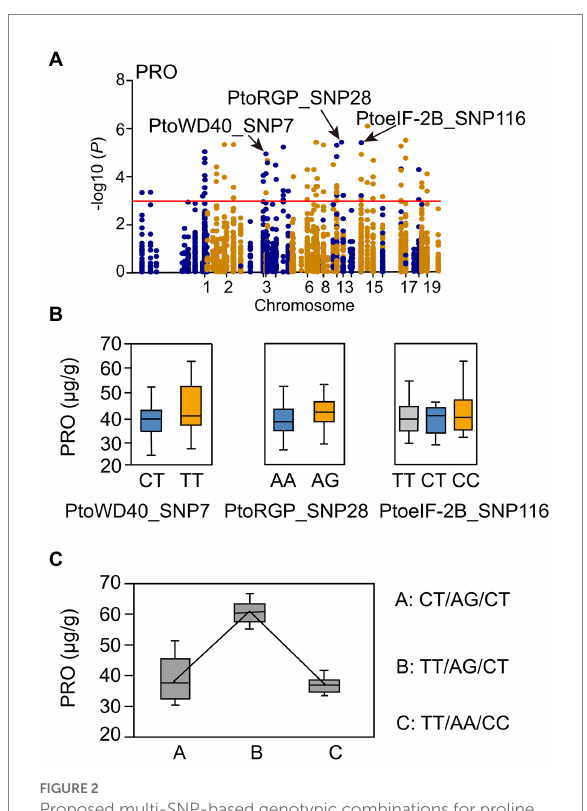
FIGURE 2 Proposed multi - SNP - based genotypic combinations for proline content (PRO). (A) Manhattan plot for PRO marked with candidate genes. (B) Genotypic effects of causal SNPs for PRO. (C) Three possible genotypic combinations with a frequency of ≥ 5% from the three allelic variations, and the genotypic combination effects for proline content in the P. tomentosa association population. SNPs in each genotypic combination were ordered according to (B)